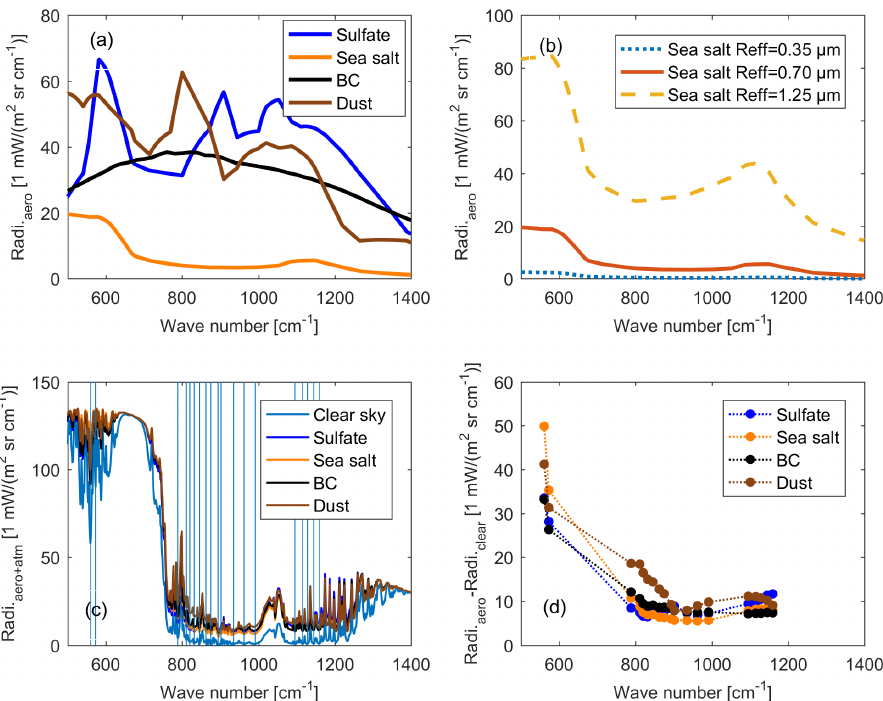
Figure 4. (a) Emission spectra of small aerosol particles (dust – brown, sulfate – blue, sea salt – orange, and BC – black) with a R eff = 0.35µm and a number density = 2000cm − 3 ; (b) emission spectra of sea salt with different particle sizes; (c) emission spectra of = 0.1) with atmospheric gases and for the clear-sky case; and (d) the difference between the total emission spectra of aerosols (AOD 900cm − 1 the aerosol and clear-sky cases in microwindows. The vertical blue lines in panel (c) show the middle values of the microwindows selected for retrieval. The emission spectra are simulated from LBLDIS with a resolution of 1cm − 1 . Table 2. Parameter errors and modifications for artificial